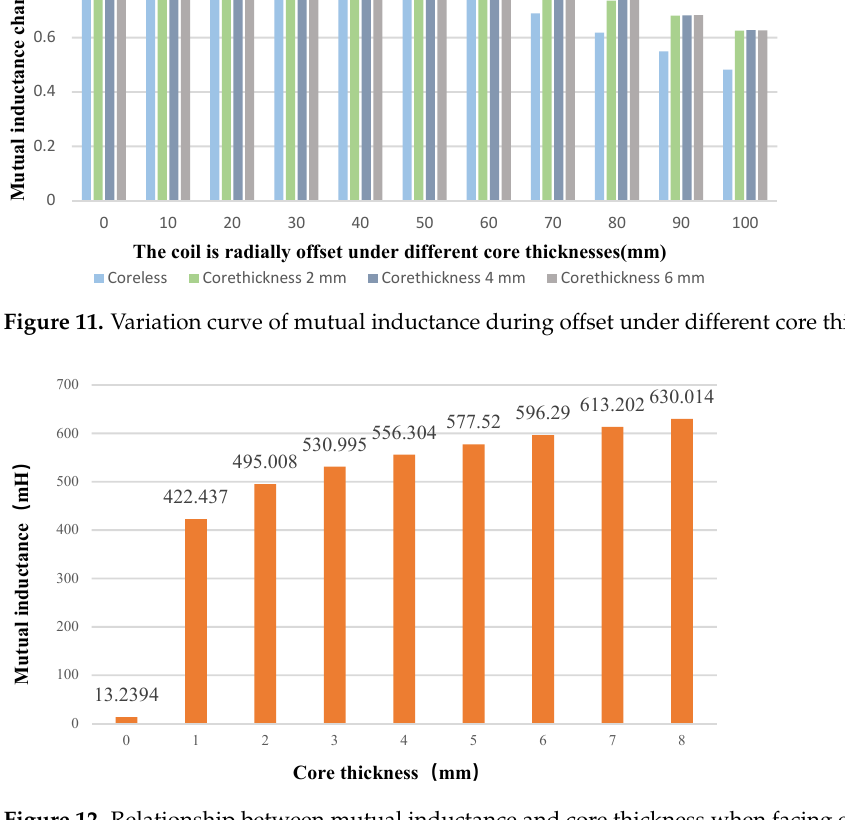
Figure 12. Relationship between mutual inductance and core thickness when facing each other.